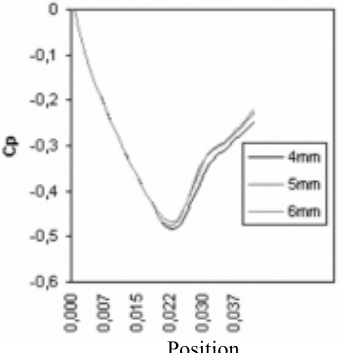
Fig. 7 - Pressure coefficient (Cp) in the subclavian artery in respect to the angle of the anastomosis (A) and of the diameter of the PTFE graft. It is possible to observe that the pressure drop is very similar to the variations of the angle of the anastomosis and the diameter of the graft